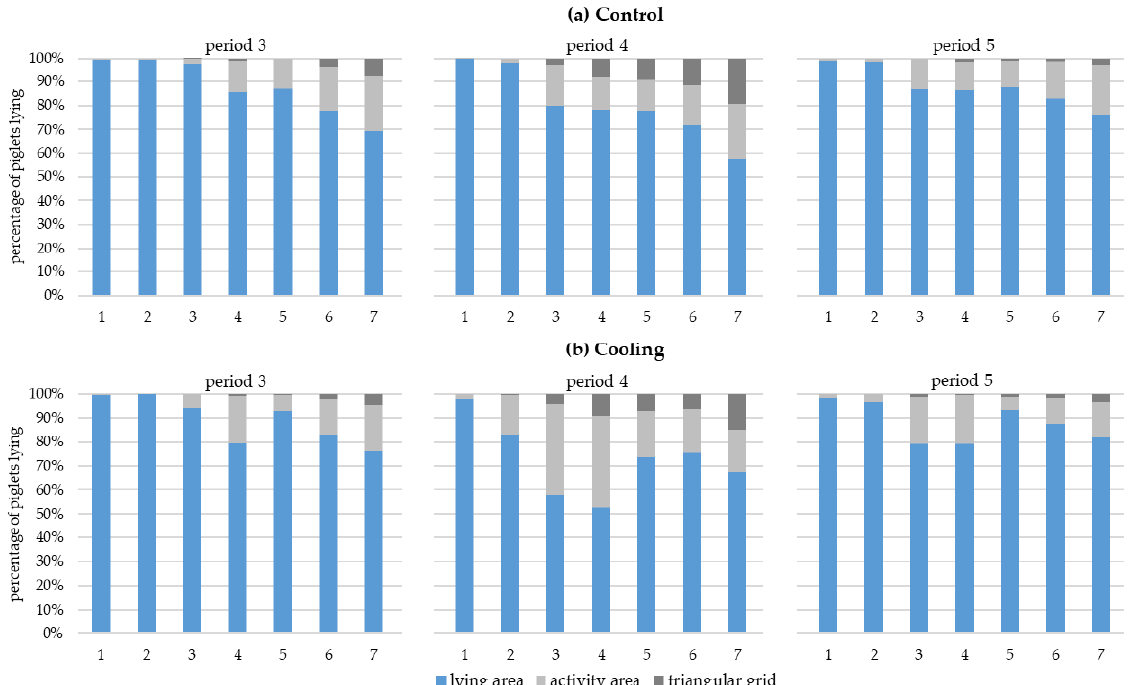
Figure 6. Percentage of piglets (96 piglets per period) lying on the lying area, the activity area, or the triangular grid. ( a ) Data of the three rearing periods of the control pens; ( b ) data of the three rearing periods with a cooled floor. There were usually n = 124 scan-sampling observations for each of the six graphs.